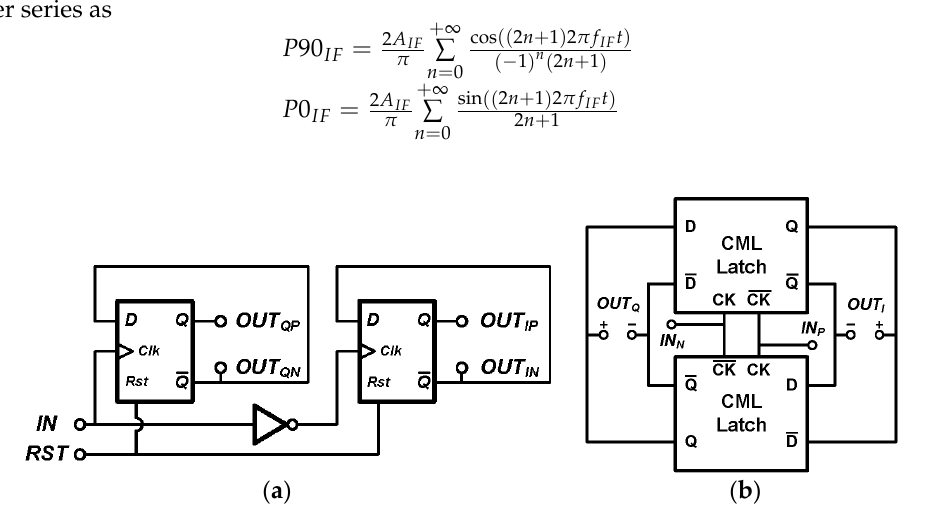
Figure 11. Divide-by-2 dividers with quadrature output ( a ) for IF signal generation; ( b ) for RF signal generation.